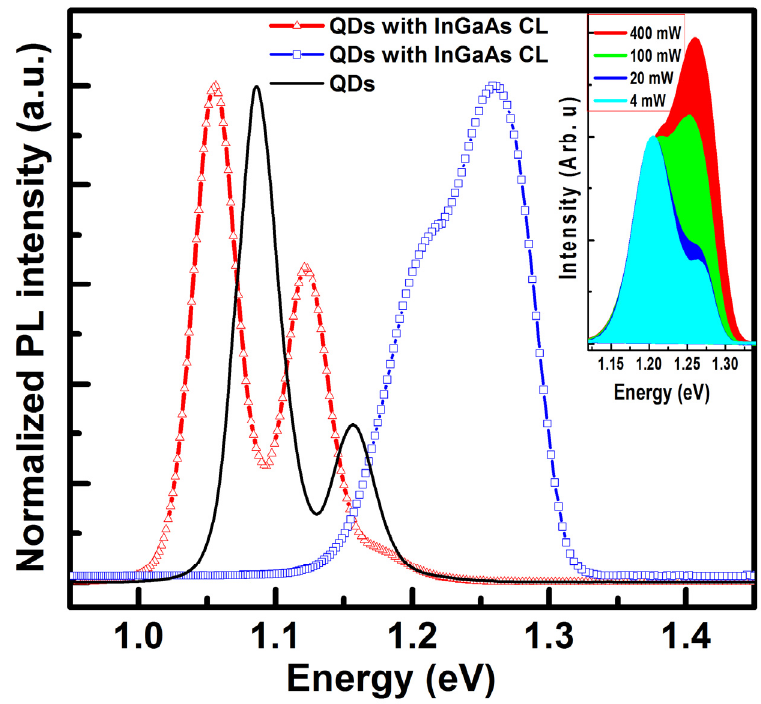
Figure 3. 12 K PL spectra taken with an excitation power of 400 mW, from the reference InAs QDs in a pure GaAs matrix and from the InAs QDs with SRL as a cap layer (empty triangles) and as an underlying layer (empty squares). The Inset shows the excitation power dependent PL spectra from the InAs QDs with InGaAs underlying